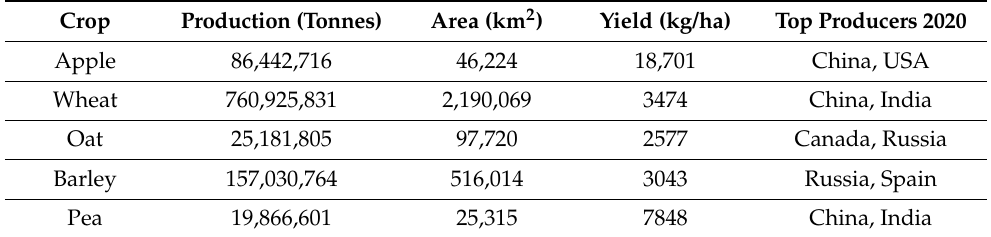
Table A1. Production, area and yield of biomass